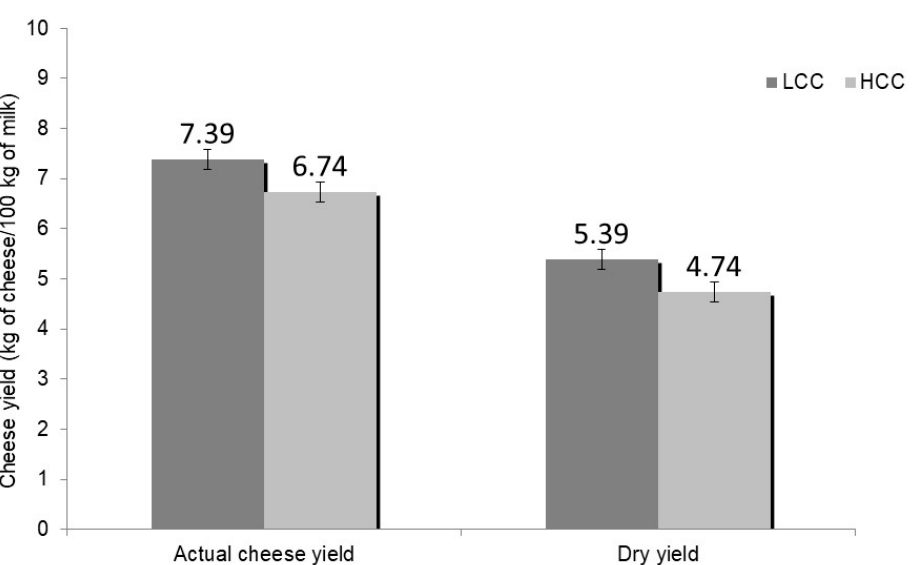
Figure 1. Cheese yield at 24 months ripening from milk with less than 400,000 (Low Cell Count (LCC)) and more than 400,000 cells/mL (High Cell Count (HCC)) (least square mean values). Classification was based on SCC of the whole evening milk. For both, LCC and HCC means differ with a p -value ≤ 0.05.